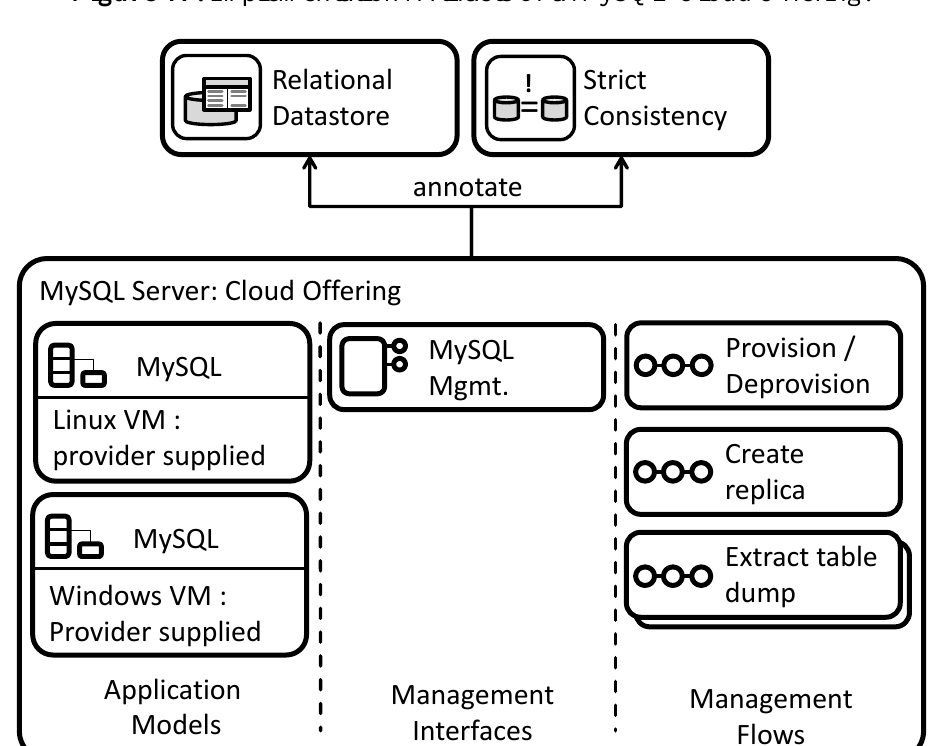
Figure 17. Implementation Artifacts of a MySQL Cloud